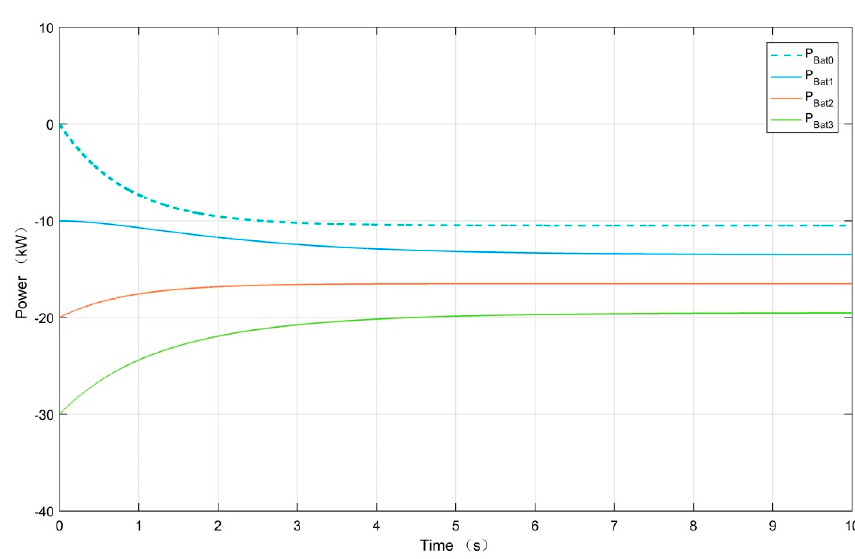
Figure 10. Battery power in modules.